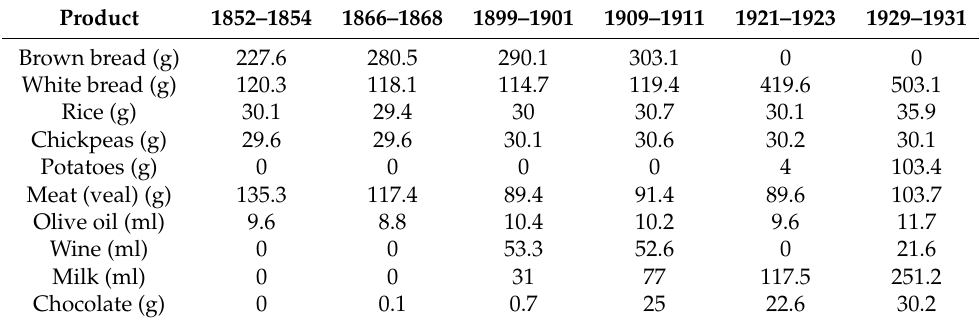
Source: see Table 1. ADPV, secci ó n Hospital, II.1.14, V-2.3/C-15, Clasificaci ó n del personal que se calcula atender á este establecimiento de 1899 a 1900 [ . . . ] , 1900. ADPV, secci ó n Hospital, II.2.3, V-7.6/3, 6, 7, 13, 14, libros de